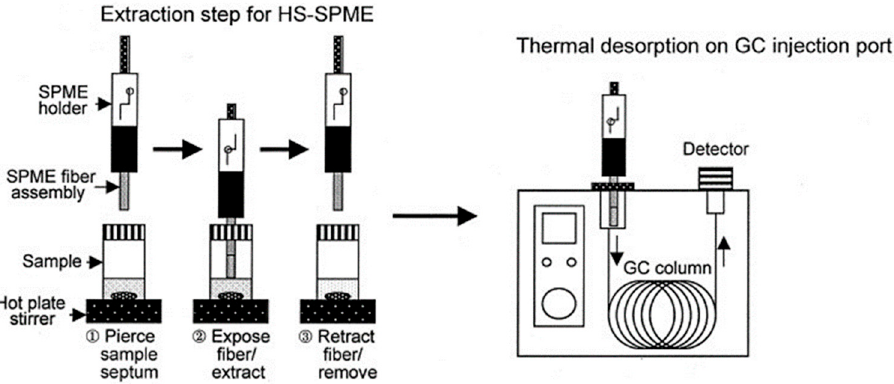
Figure 2. Diagram of HS-SPME device procedure. Reprinted from Journal of Chromatography A , vol 880, Kataoka H, Lord LH, Pawliszyn J, Applications of solid phase microextraction in food analysis, pg. 35–62, Copyright (2000), with permission of Elsevier.